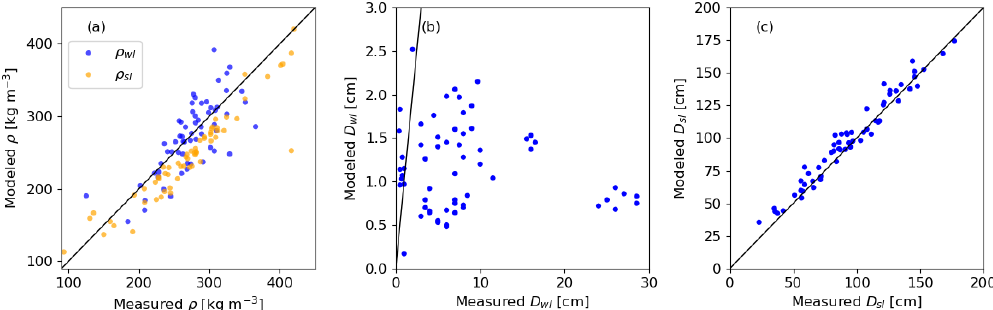
Figure 4. Comparison of (a) modeled to measured weak layer density ρ wl and mean slab density ρ sl , (b) weak layer thickness D wl , and (c) slab thickness D sl . Modeled properties were taken from SNOWPACK simulations while measured properties come from manually observed snow profiles. The black line is the 1 : 1